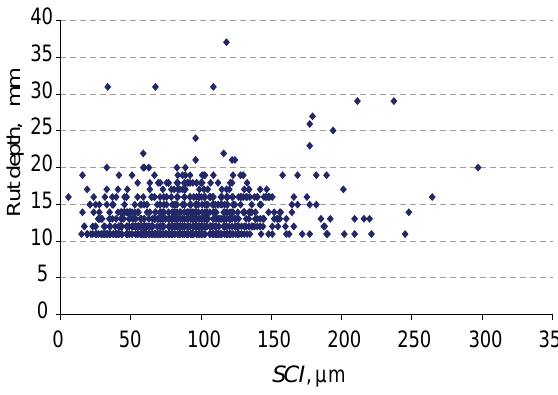
Fig. 2. Values of SCI when rut depth > 10 mm, analyze group